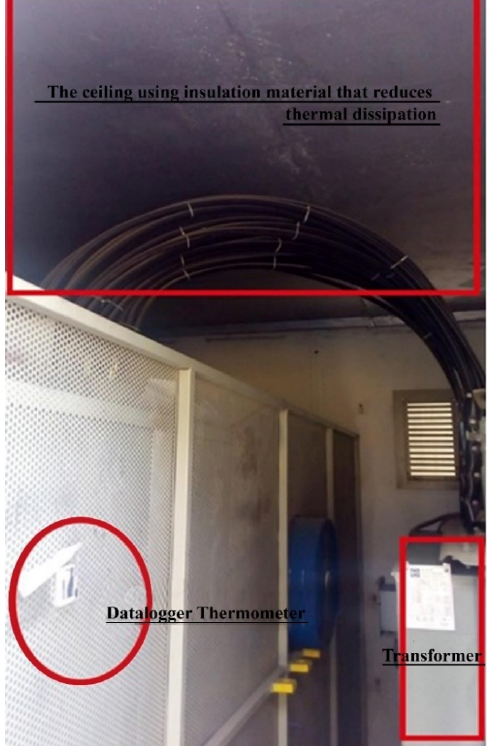
Figure 2. Location of the data loggers in the transformer building.